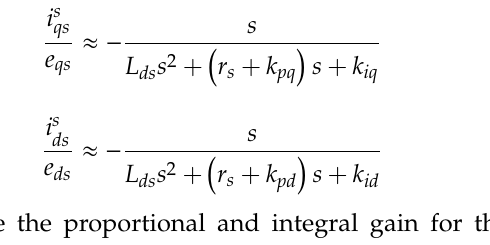
Figure 5. Frequency response of the induced current.